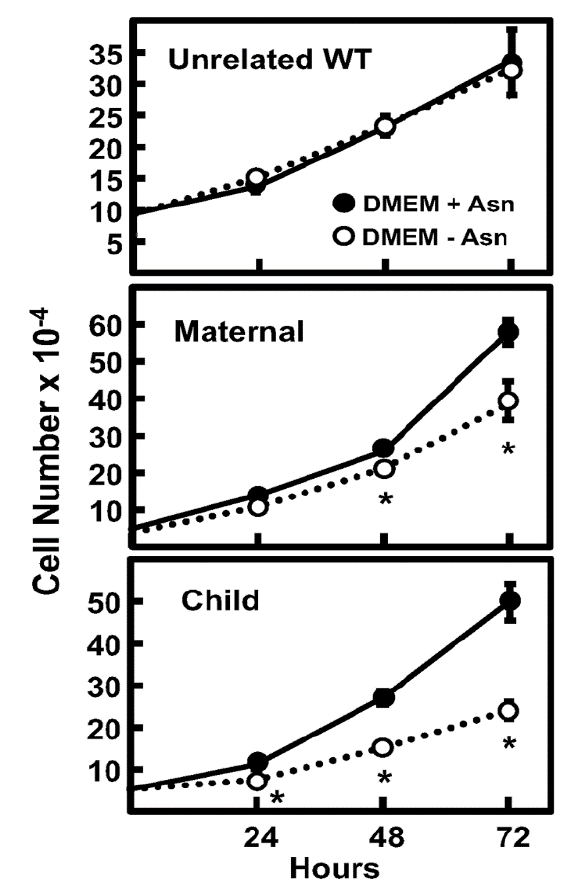
Figure 5. Cell proliferation of primary fibroblasts from mother and child with ASNS variants. The cell counts of WT, maternal, and child fibroblasts were measured from 0 to 72 h during incubation in DMEM ± Asn. The data are the averages ± standard deviations of three determinations, and an asterisk indicates that the DMEM - Asn value is statistically different from the DMEM + Asn condition with a p -value of ≤ 0.05.